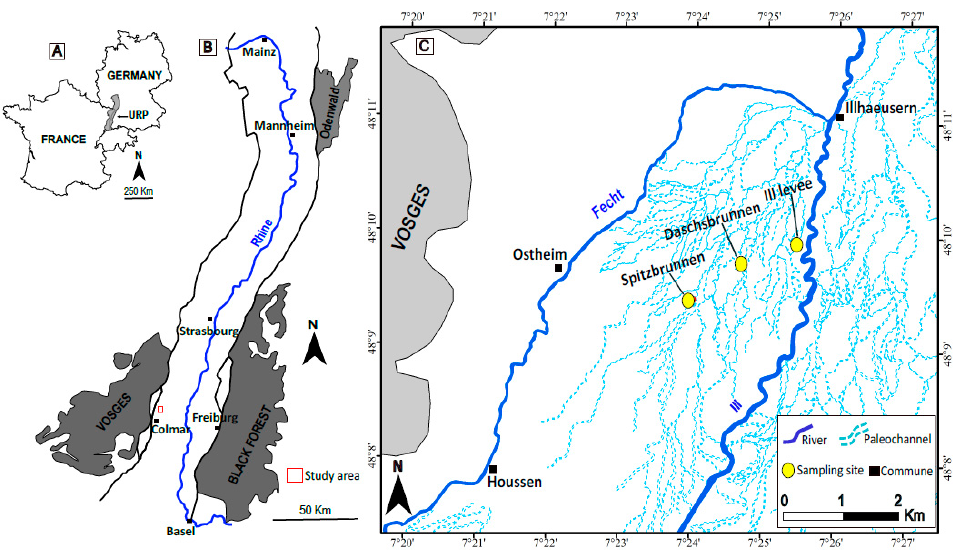
Figure 1. Maps showing ( A ) the location of the Upper Rhine Plain in Europe, ( B ) the location of the study area within the Upper Rhine Plain, and ( C ) the location of sample sites.